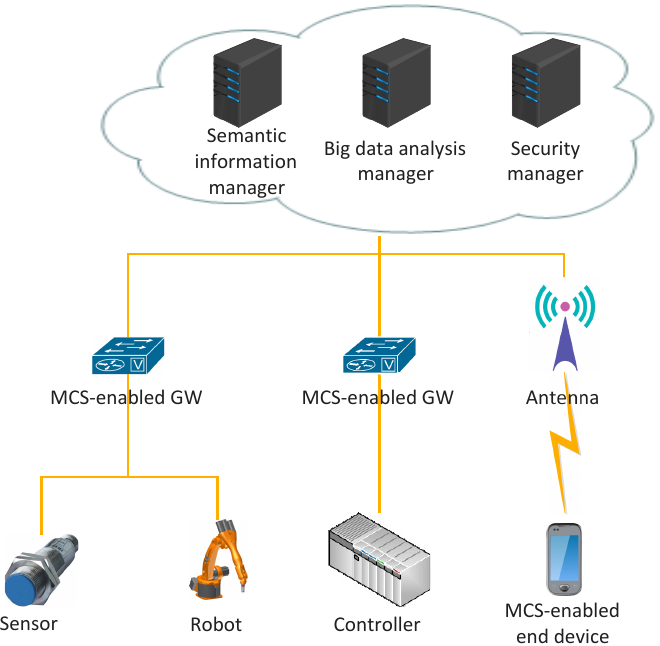
Figure 4. Example MCS-enabled architecture for Industry